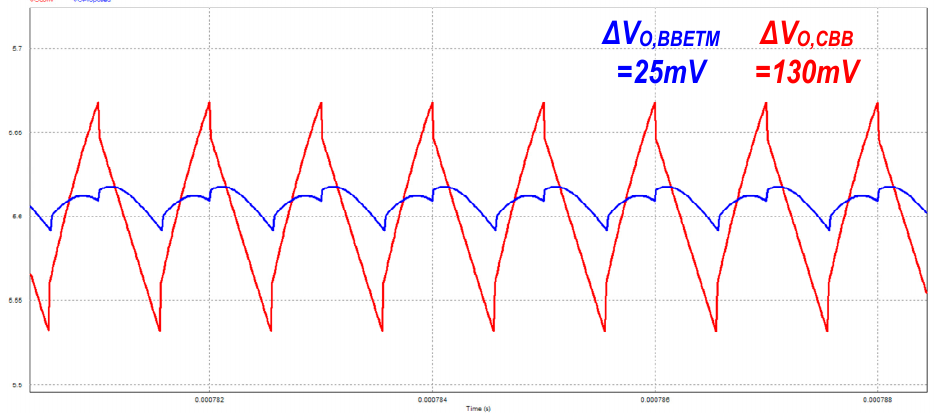
Figure 16. Simulated output voltage ripple of BBETM compared with CBB .